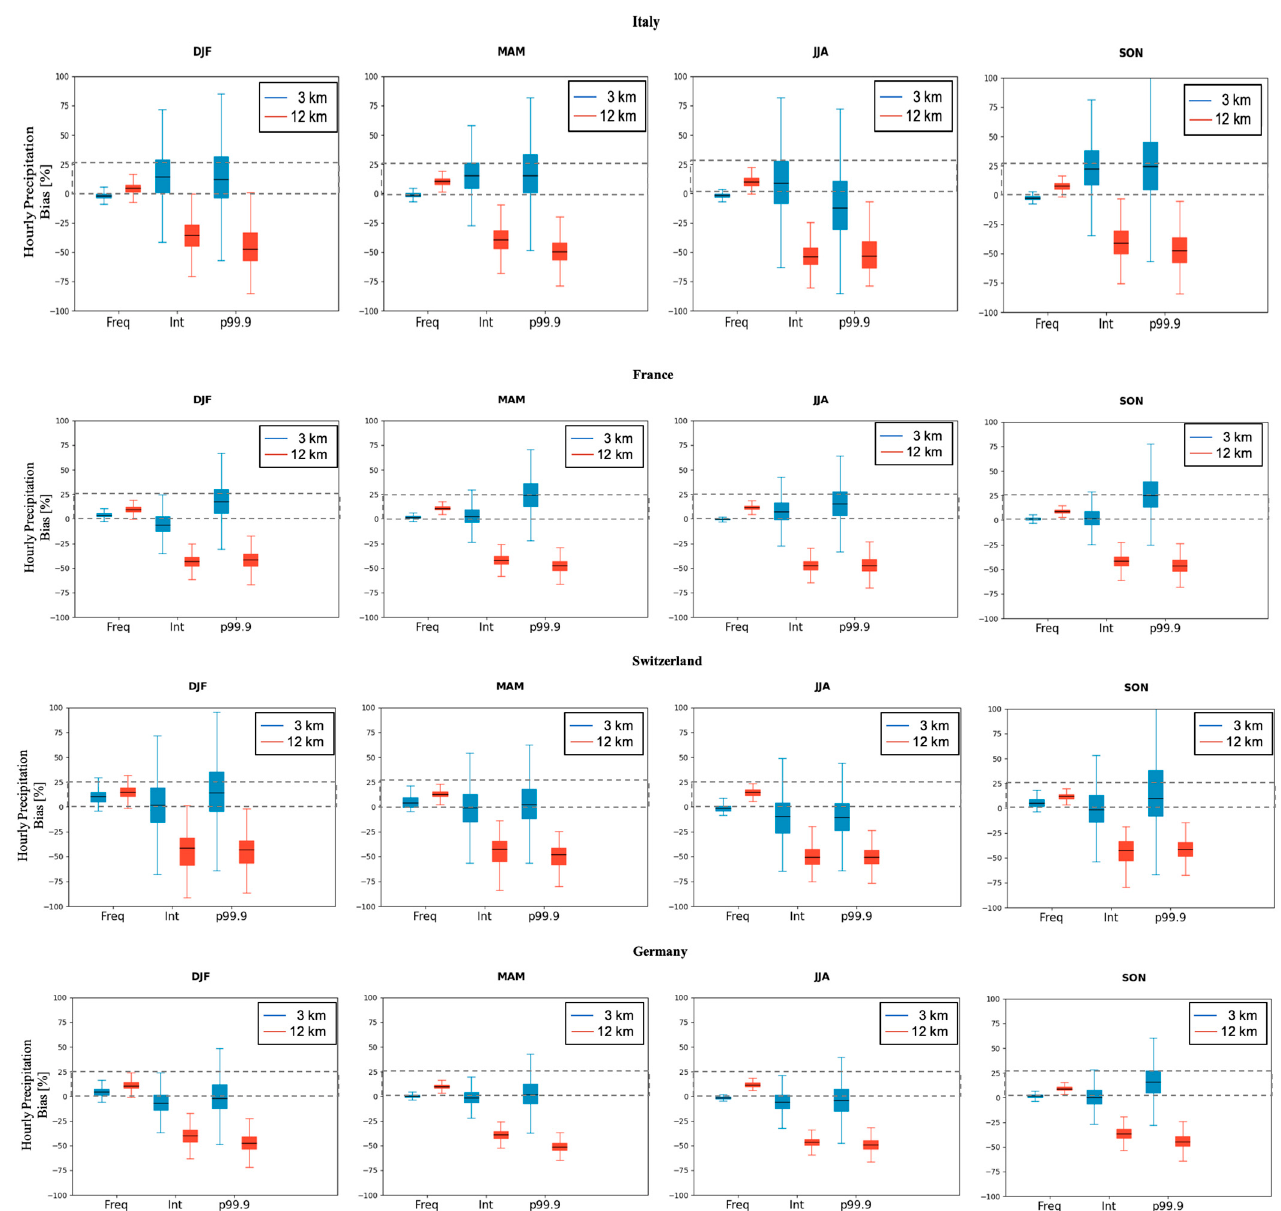
Figure 12. Similar to Figure 11, but for hourly precipitation over four regions: Italy, France, Switzer- land, and Germany. Heavy hourly precipitation is defined as the 99.9th percentile (p99.9) of all events.